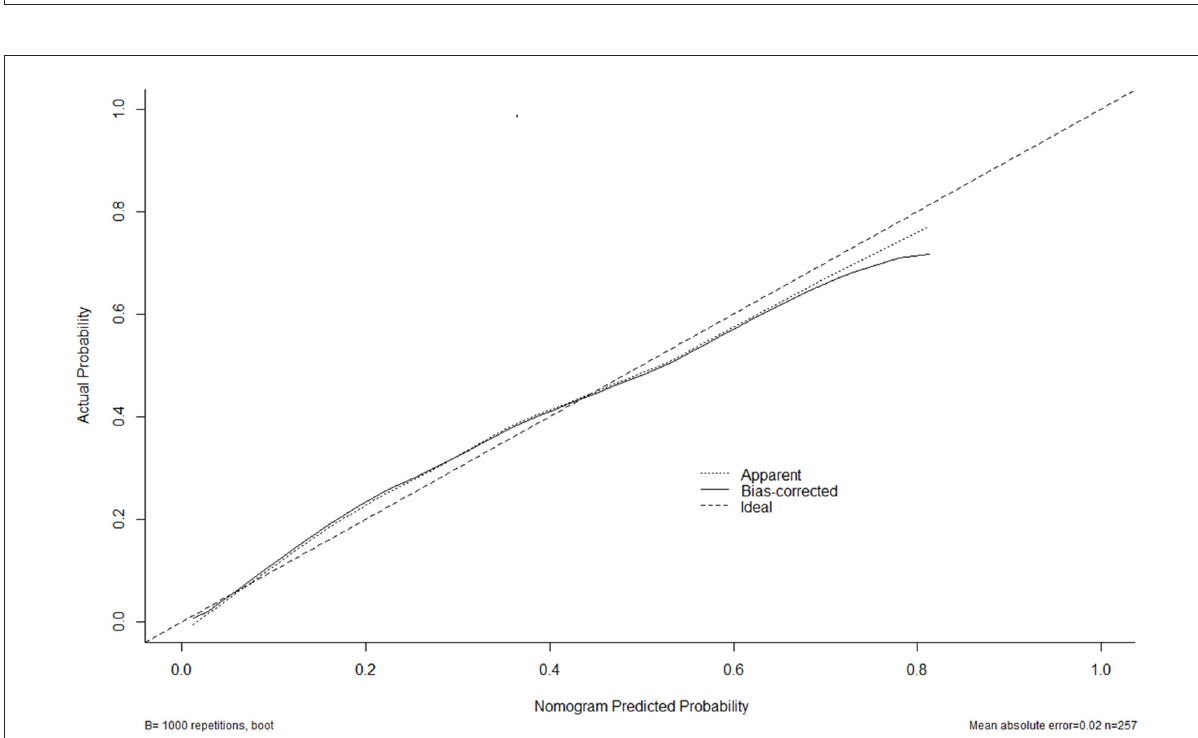
FIGURE6 Calibration curves of the nomogram for predicting delayed cerebral ischemia among patients with aneurysmal subarachnoid hemorrhage. The x -axis denotes the predicted delayed cerebral ischemia. The y -axis denotes the actual delayed cerebral ischemia. The diagonal dotted line means a perfect prediction using an ideal model. The solid line represents the performance of the nomogram, of which the closer fit to the diagonal dotted line indicates the better prediction of the